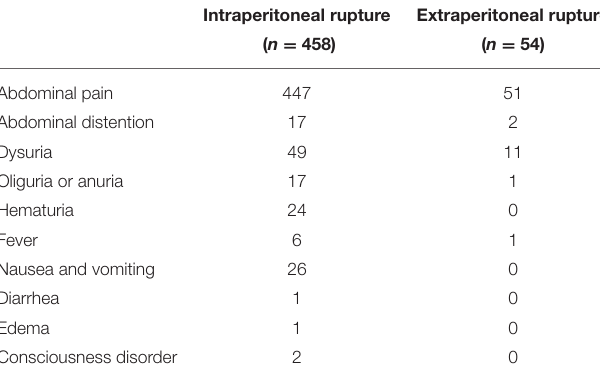
TABLE 1 | Basic characteristics of cases included. TABLE 2 | Main symptoms of cases included.